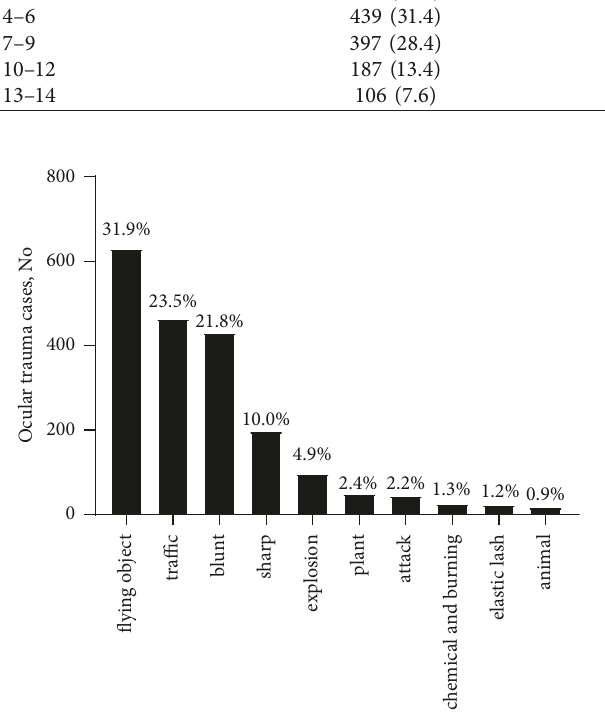
Figure 2: Distribution of pediatric ocular trauma caused by the type of injury from 2019 to